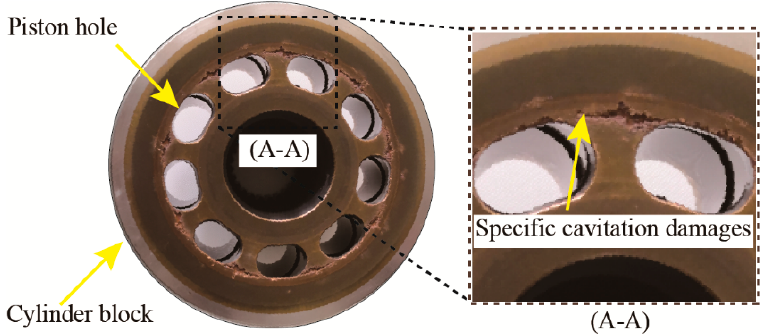
Figure 1. Specific cavitation damage to axial piston pumps.